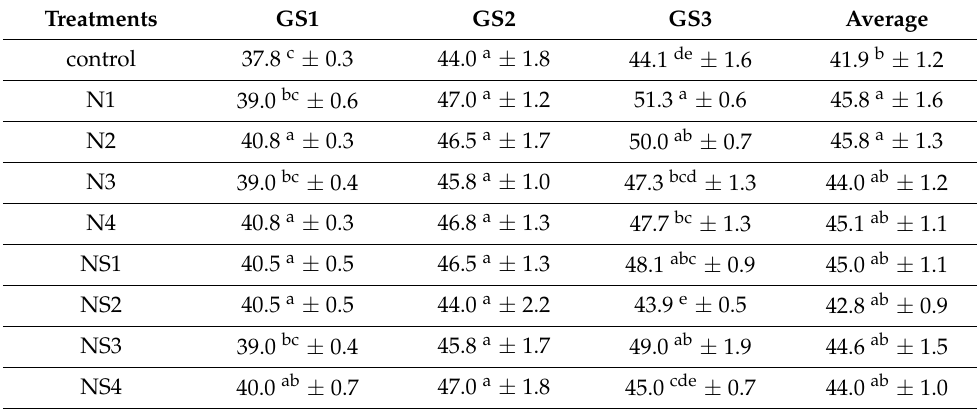
Table 6. The effect of fertilizer treatments on the Zeleny-test values (mL). Treatments